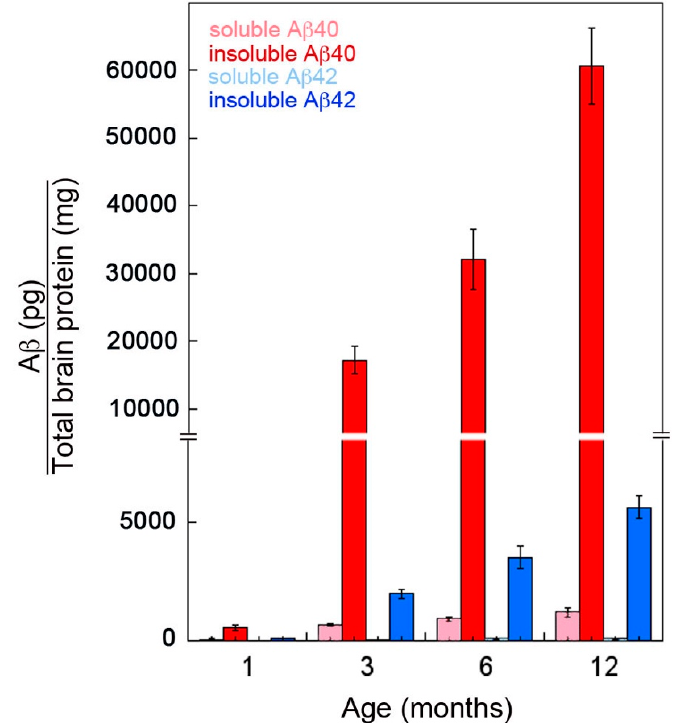
Figure 1. Progressive accumulation of A β peptides in rTg-DI rats. The levels of soluble and insoluble A β 40 and A β 42 peptides in the forebrain of rTg-DI rats aged from one to twelve months were measured by ELISA as described in “Methods”. The data presented are the means ± S.D. of triplicate measurements performed in 5–6 rTg-DI rats per age group.